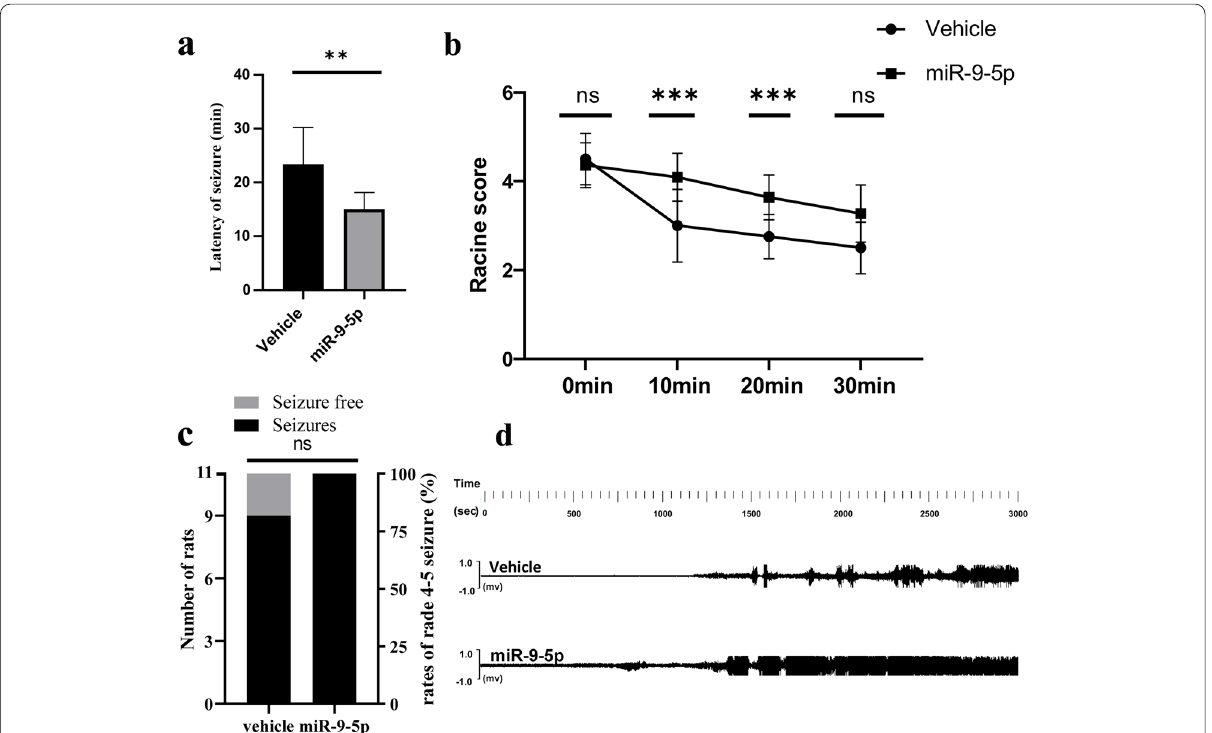
Fig. 2 Effects of miR-9-5p overexpression on lithium-pilocarpine-induced seizure activity in rats. a Effects of miR-9-5p overexpression on seizure latency. b Racine scores at different time points after seizure onset. c Comparison of seizure rate. d Representative EEG recordings of lithium-pilocarpine-induced seizures in the miR-9-5p and vehicle groups